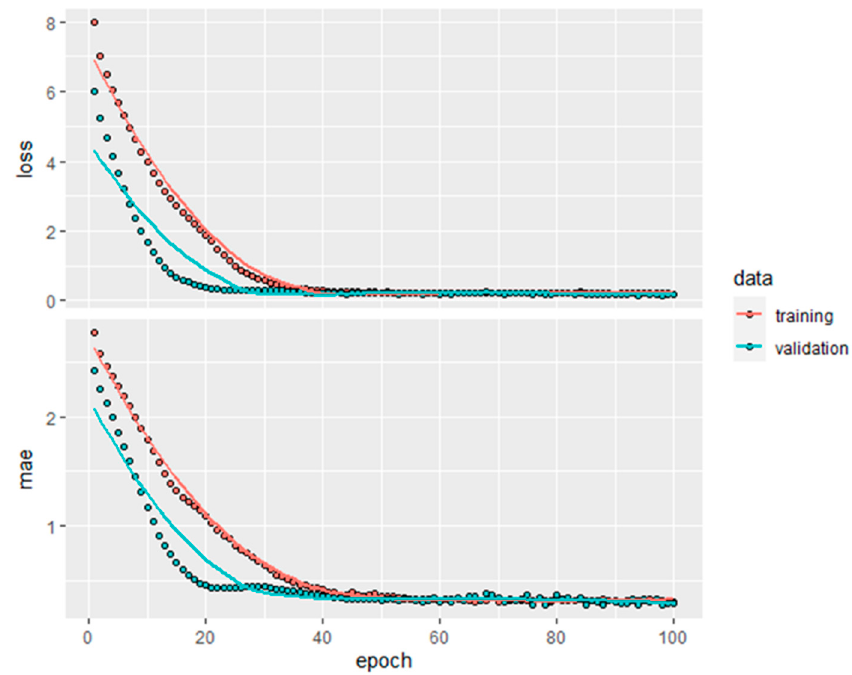
Figure 4. MSE and MAE as a function of number of epochs.